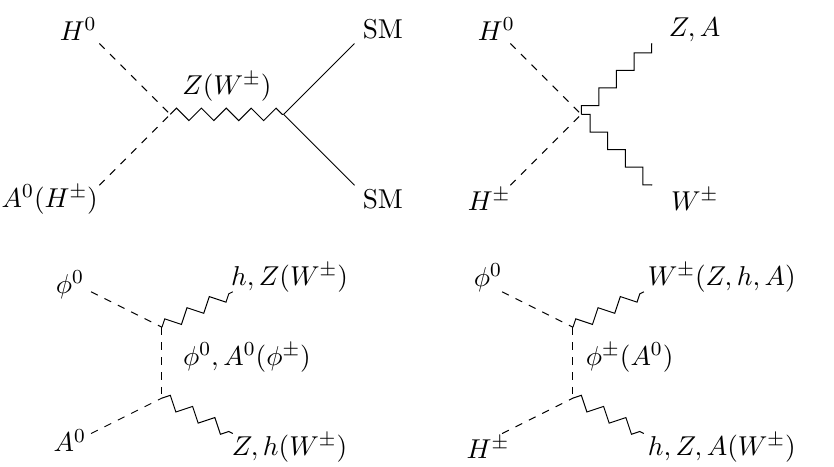
Figure 28. Feynman diagrams for DM co-annihilation to SM particles for the Scalar DM ( φ 0 ) associated with heavy states ( A 0 , φ ± ).